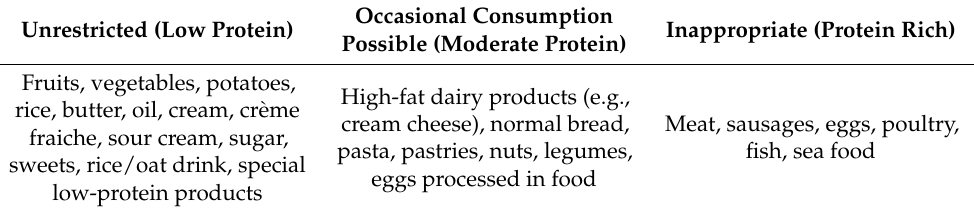
Table 1. Simplified choice of food by using three categories according to protein content as developed in the workshop in